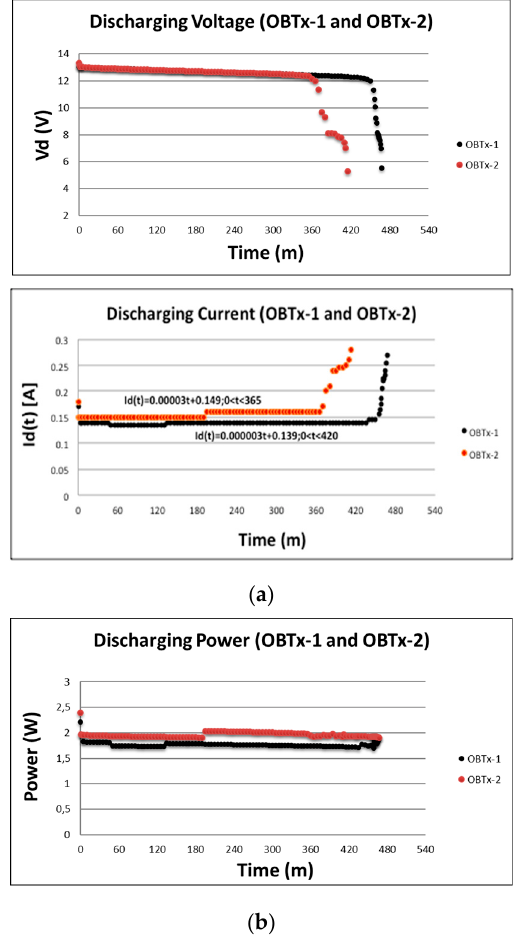
Figure 11. ( a ) Evolution of V d and I d in time. ( b ) Evolution of power consumption in time ( T d ).